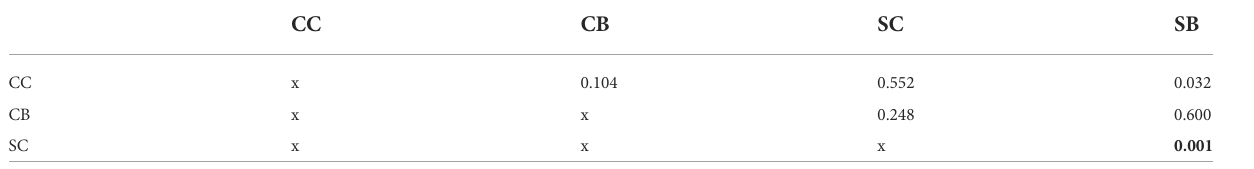
Table 4D: p -values for beta band — post/pre (N/A, no signi fi cant differences observed